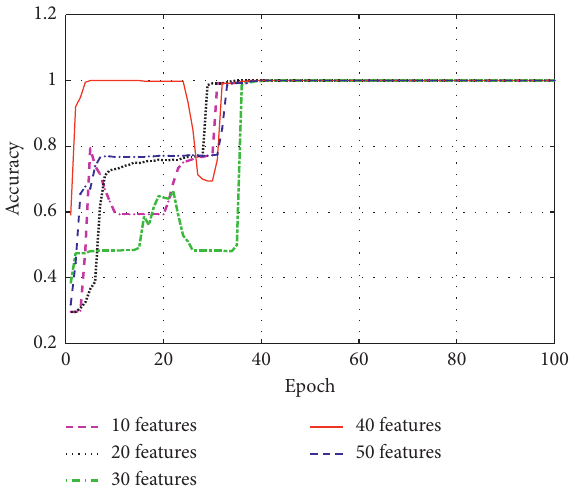
Figure 8: Accuracy of the CNN. Figure 9: Accuracy of the